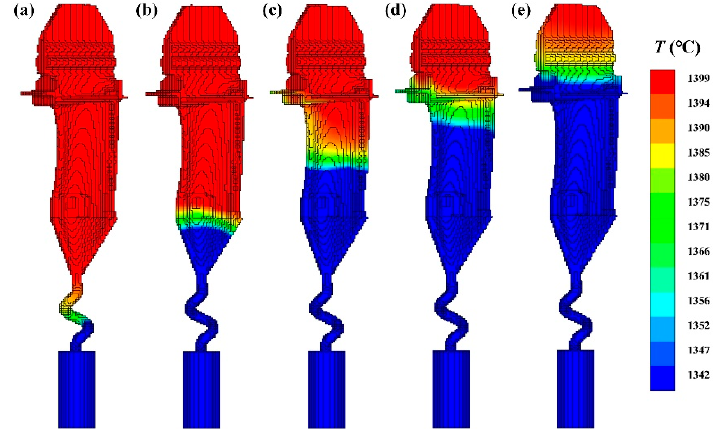
Figure 4. The temperature distribution and mushy zone evolution by the LMC technique at a constant withdrawal rate of 8 mm/min: ( a ) t = 205 s, f s = 30%; ( b ) t = 689 s, f s = 40%; ( c ) t = 910 s, f s = 50%; ( d ) t = 1031 s, f s = 60%; and ( e ) t = 1193 s, f s = 80%. In this figure, f s stands for fraction solid.